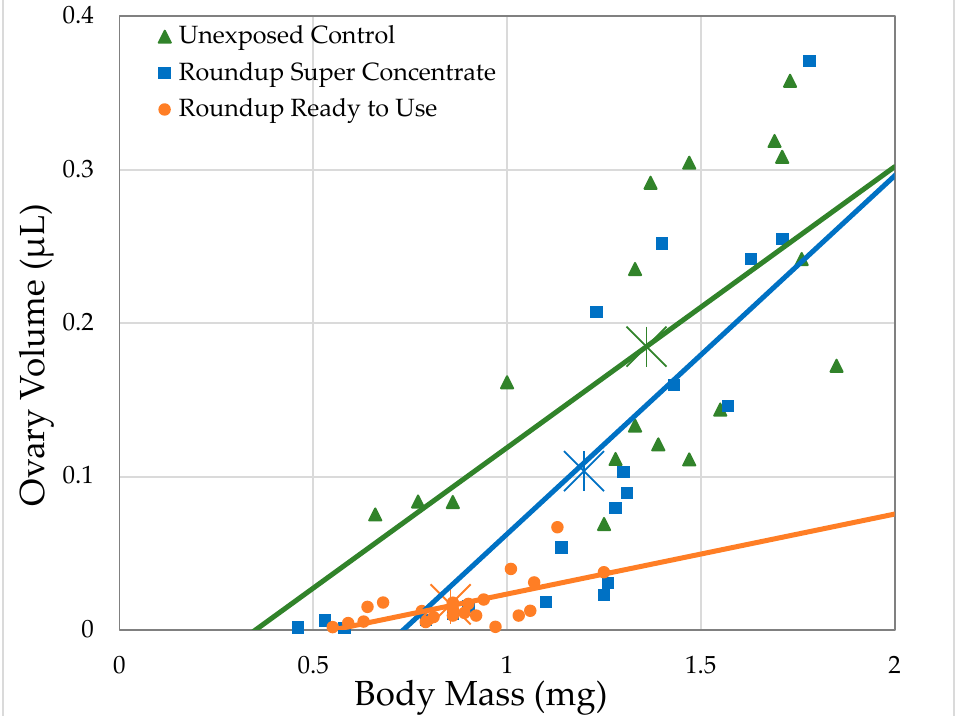
Figure 3. Relationship between ovary volume and body mass of D. melanogaster females exposed to herbicide in their food medium at the highest concentrations used (4.64 mL/L Roundup ® Super Concentrate and 168.8 mL/L Roundup ® Ready to Use; each corresponds to 2 g/L glyphosate) within 2 h of eclosion for 7 days, compared to the ovary volume of females exposed to the control medium. Both Roundup ® formulations, at all concentrations tested, reduced ovary size in fe- male Drosophila , exposed within 2 h of eclosion for 7 days, relative to unexposed control females ( t -tests; Figures 4 and 5; Table 2). While glyphosate and Roundup ® Super Concen- trate reduced ovary size in a non-dose-dependent manner, pelargonic acid and total herbicide concentration, as well as concentration of Roundup ® Ready to Use, did correlate with ovary size. When exposed to Roundup ® Ready to Use at 4 g/L of combined active in- gredients, average ovary volume decreased to 9% of the unexposed control. Only 0.16 g/L of combined active ingredients were required, as part of the Roundup ® Ready to Use formulation, to reduce ovary volume to half that of controls (EC 50 , Table 3).